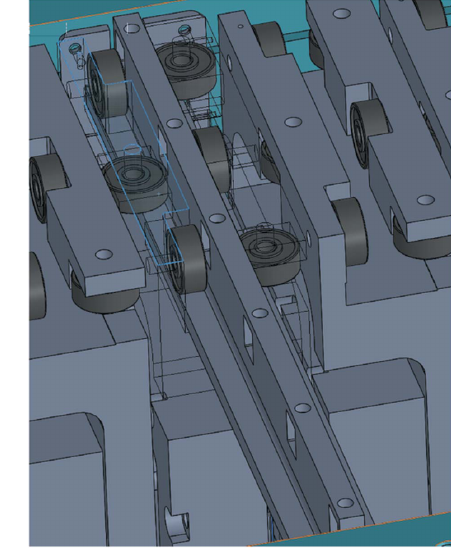
Figure 8 Diagram of the foil carrier and six-ball-bearing